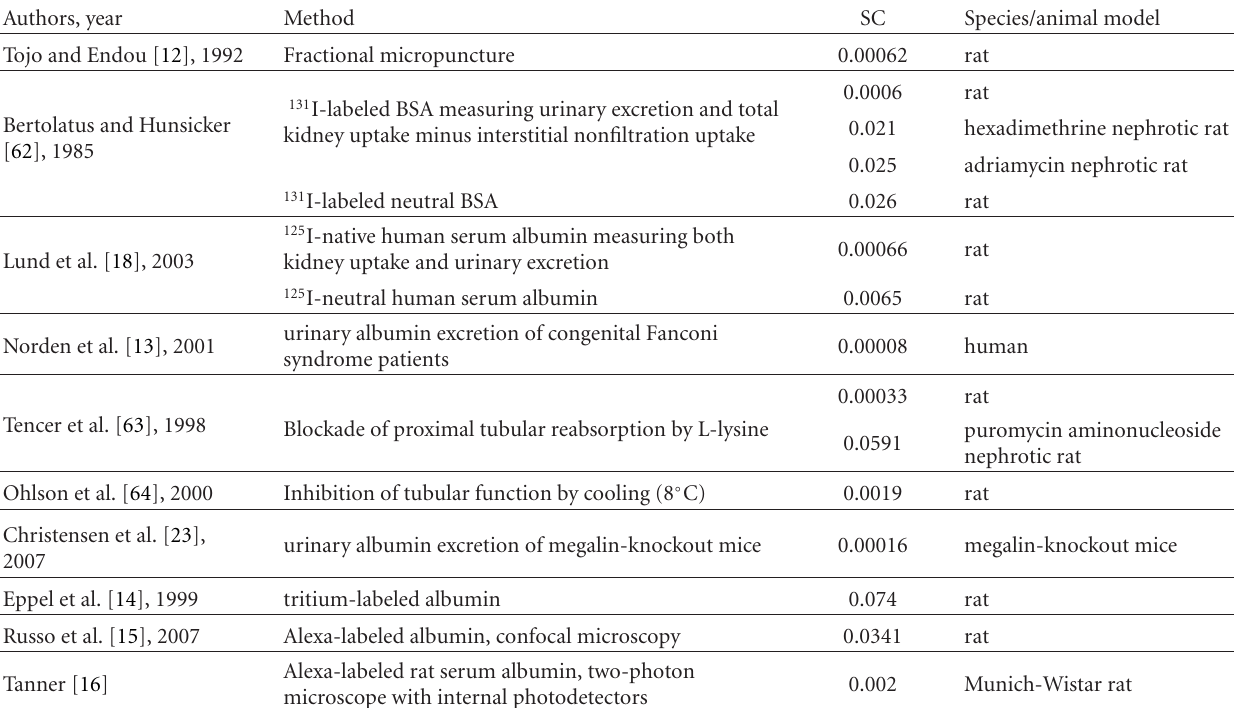
Table 1: Comparison of the glomerular albumin-sieving coe ffi cient (SC)